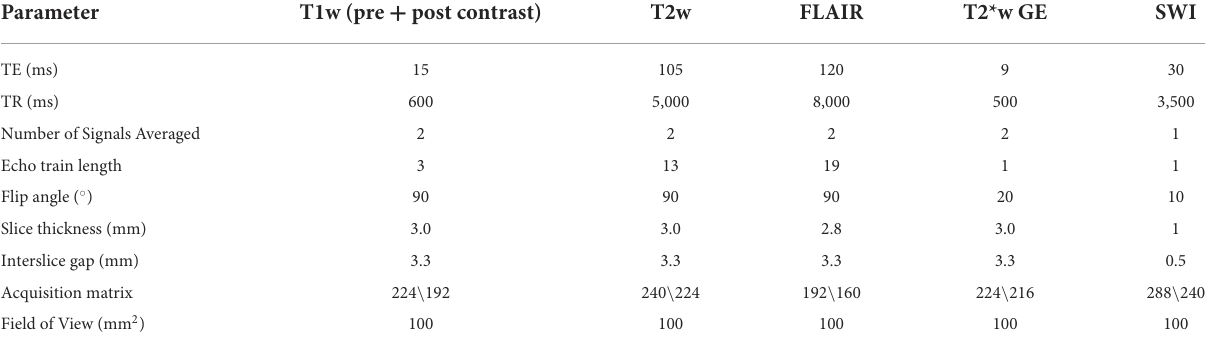
TABLE 2 MRI acquisition parameters